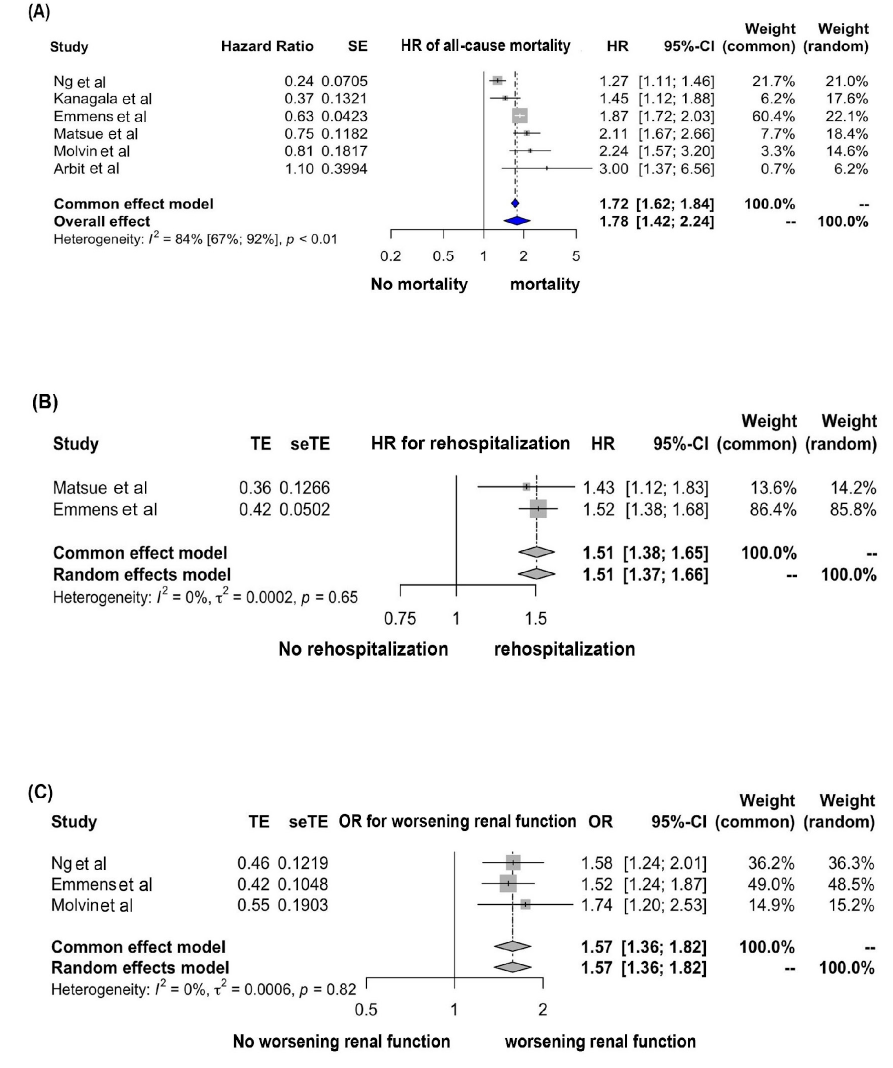
Figure 2. Forest plots of the included studies evaluating the associations of plasma PENK levels at the time of admission and their predictive prognosis including all-cause mortality [5,7–11] ( A ), rehospitalization [9,10] ( B ), and worsening renal function [7,10,11] ( C ) in patients with heart failure by using a random-effect model. Square data markers show hazard ratios (HRs) and odds ratios (ORs); horizontal lines show the 95% confidence intervals (CI), with the marker size indicating the statistical weight of the study using random-effects meta-analysis. A diamond marker shows the overall HRs or ORs and the 95% CI for the outcome of